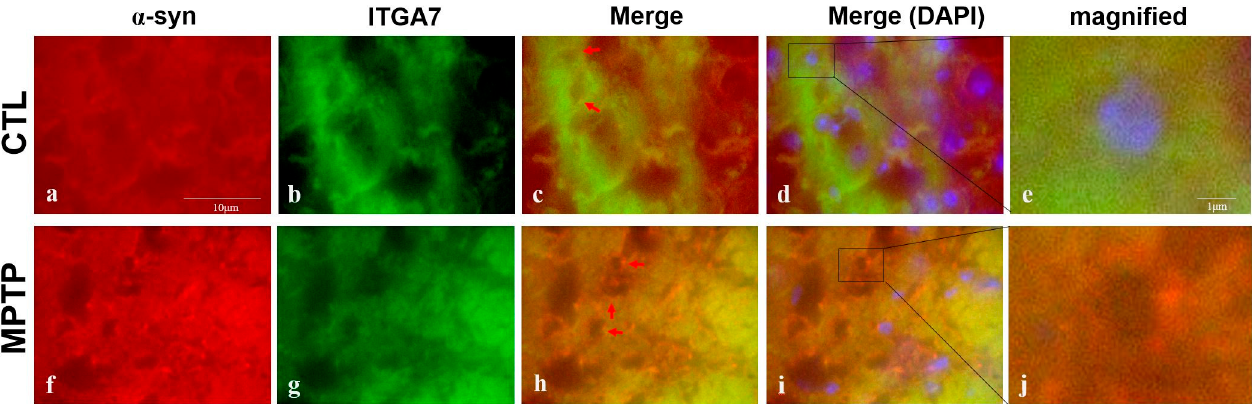
Figure 3. Representative images of (ITGA7) and α -synuclein ( α -syn) expression in the SN in a chronic 1-methyl-4-phenyl- 1,2,3,6-tetrahydropyridine (MPTP)-induced Parkinson’s disease mouse model. The expression of ITGA7 ( a – d ) was decreased ( c , d ) and the expression of α -syn ( e – h ) was increased ( g , h ) in in the MPTP group. Images of ( b , d , f , h ) are magnified images of squares in ( a , c , e , g ).